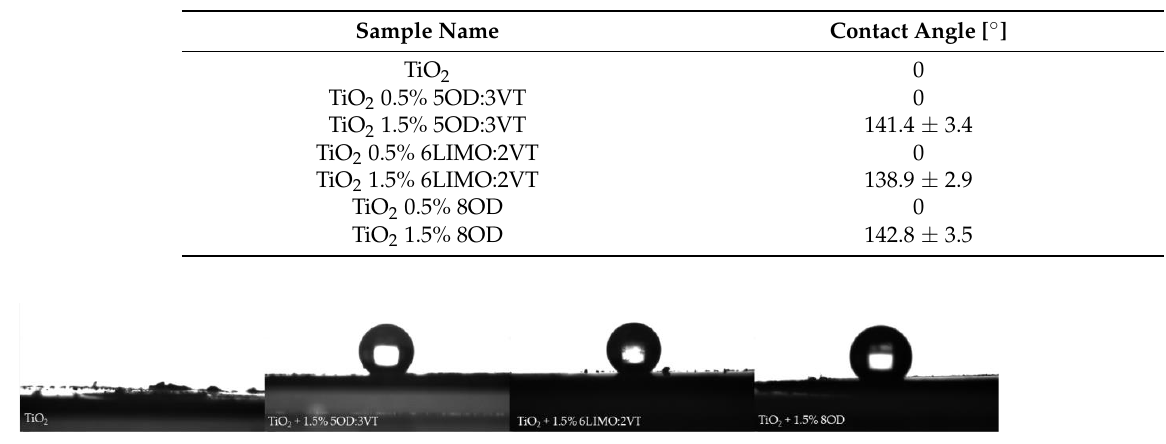
Table 5. Water contact angle of TiO 2 [ ◦ ].